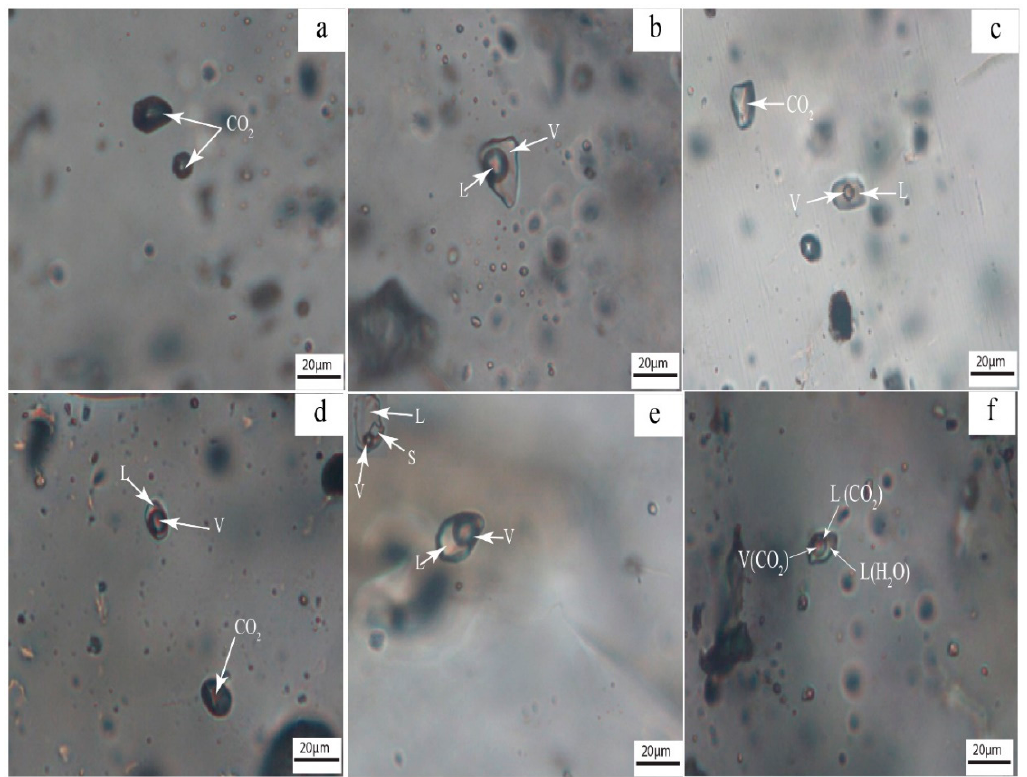
Figure 9. Photomicrographs showing di ff erent types of fluid inclusions observed in the Nabeba deposit. ( a ) Type I fluid inclusions in quartz vein A (HO-1 stage); ( b ) Type IIa fluid inclusions in quartz vein